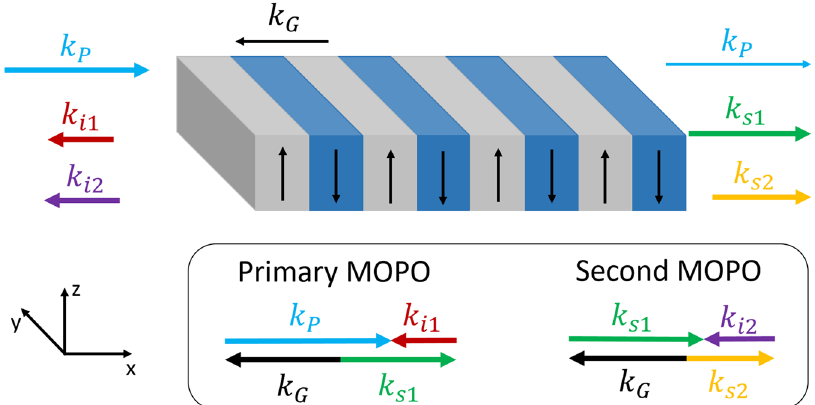
Figure 1. Cascaded MOPO scheme. Schematic of the cascaded counter-propagating interactions and wave- vector diagram for the primary and cascaded MOPO. Subscripts correspond to p - pump, G – QPM